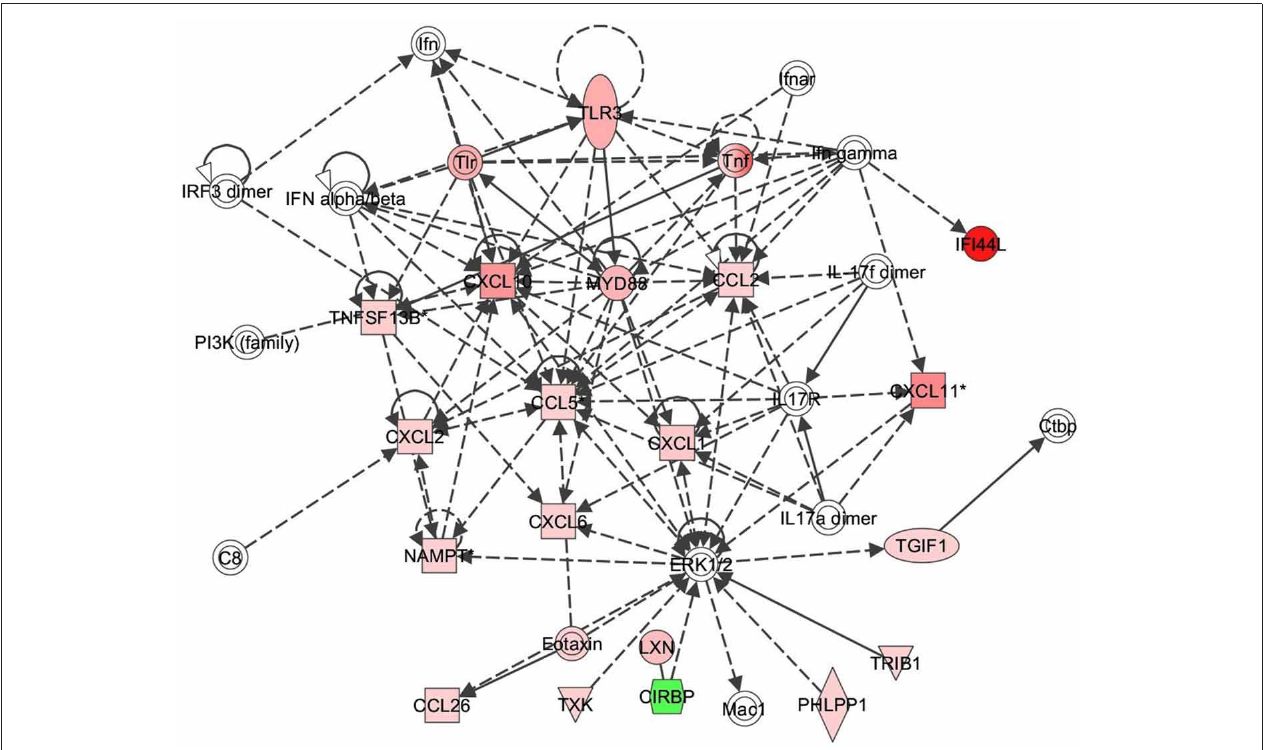
FIGURE 5 | TLR3 response signaling inflammatory network in response to Alternaria alternata spores. Genes that are significantly up-regulated are shown in red and genes that are down-regulated are shown in green. The intensity of red or green corresponds to an increase or decrease in